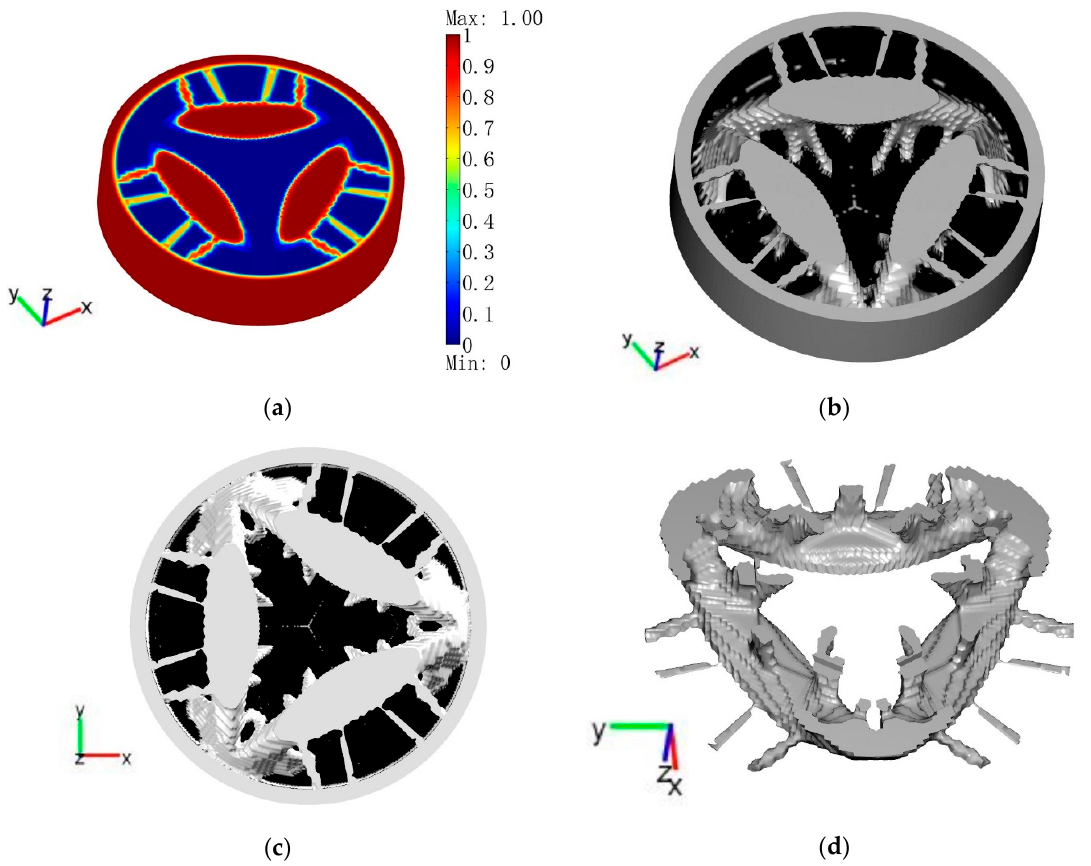
Figure 15. Optimization results in the vertical condition of the optical axis. ( a ) The density of the mirror; ( b ) Mirror structure with a density threshold of 0.6; ( c ) Top view of the optimized mirror; ( d ) Optimal structure of the design domain.